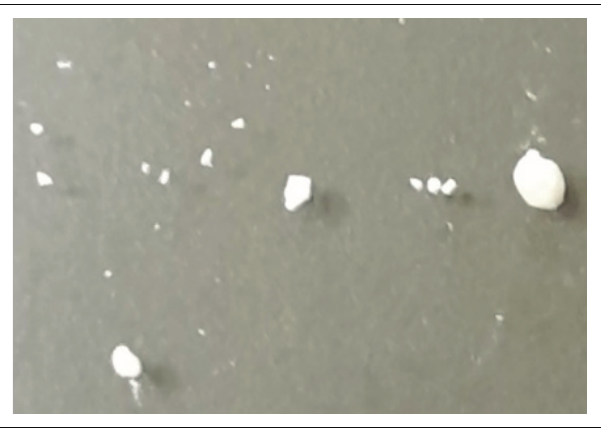
FIGURE 3: Macroscopic view of magnesium calcium phosphate carbonate uroliths obtained post-mortem from patient. Urolith size ranged from 1 mm to 6 mm in